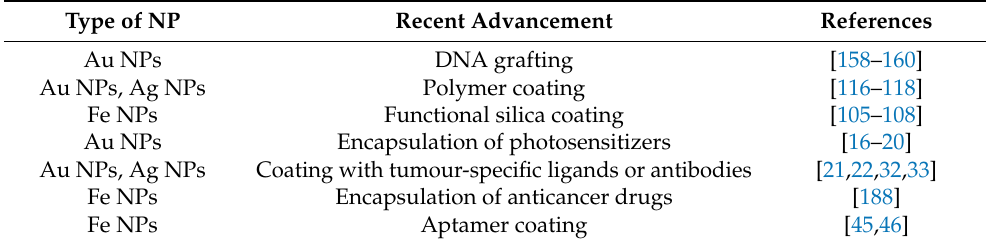
Table 13. Recent advancements in metallic/metalloid